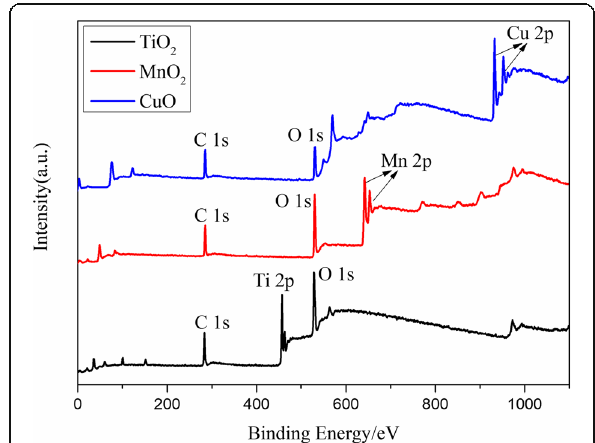
Fig. 4 XPS spectrum of TiO 2 , MnO 2 , and CuO samples